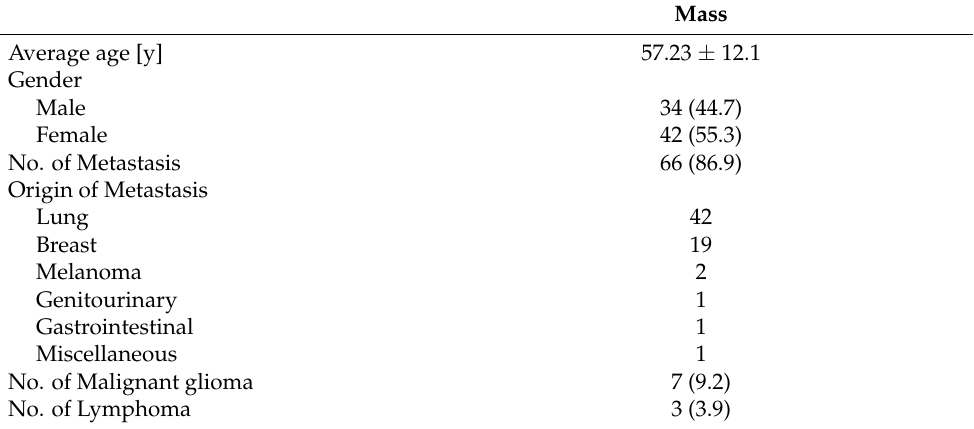
Table 2. Clinical characteristic of mass